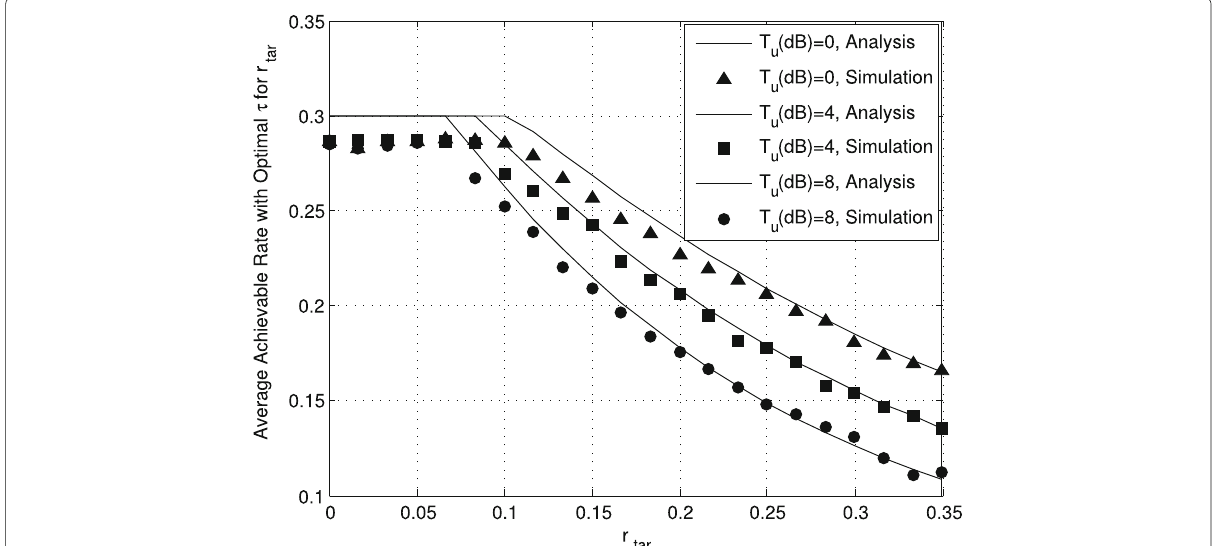
Fig. 2 Average achievable rate with the optimal TP for varying target distance with different T u when T d (dB)= − 10 (marker: simulation, line: